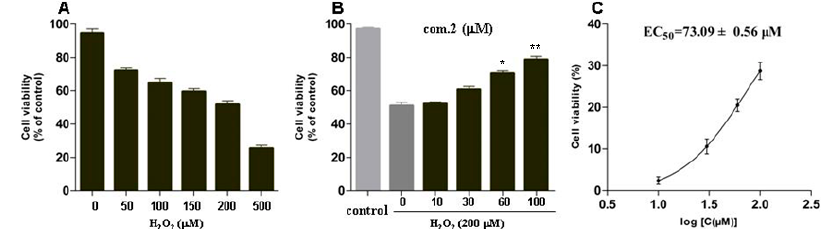
Figure 3. Protective effects of compound 2 against H 2 O 2 -induced cell oxidative stress damage in MIN6 cells. ( A ) Cells were treated with increasing concentrations of H 2 O 2 for 12 h. ( B ) Cells were treated with